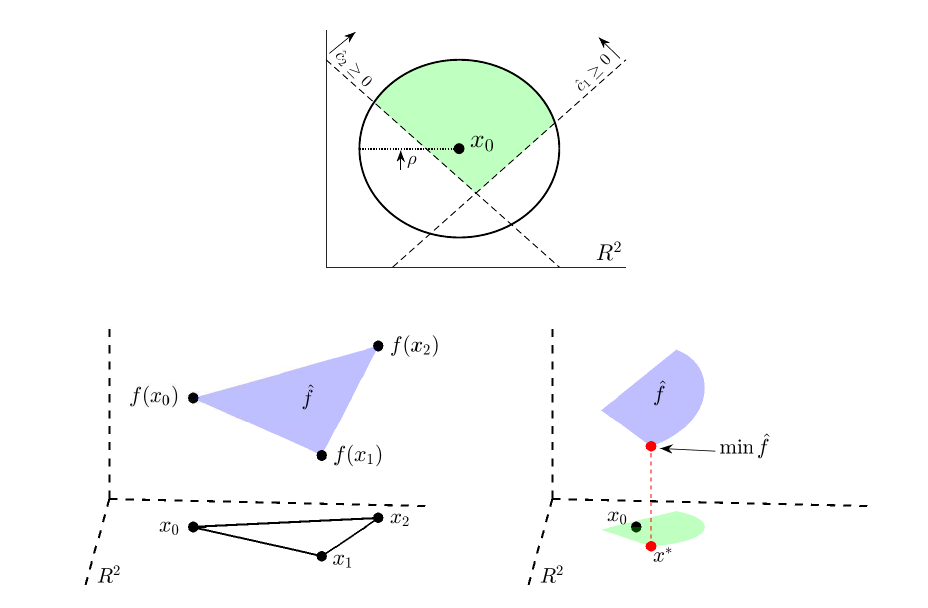
Figure A3. Minimization of ˆ f The candidate vertex x ∗ is computed by minimizing ˆ f ( x ) subject to the constraints ˆ c 1 , ˆ c 2 ≥ 0 within the trust region || x − x 0 || 2 ≤ ρ . (top) The region of optimization (green) is the intersection of the trust region || x − x 0 || 2 ≤ ρ with the half planes defined by the affine constraints ˆ c 1 ≥ 0 and ˆ c 2 ≥ 0. (bottom left) The function, ˆ f , to be minimized is represented graphically by the plane (blue) passing through points ( x 0 , f ( x 0 )) , ( x 1 , f ( x 1 )) , ( x 2 , f ( x 2 )) . (bottom right) The vertex x ∗ is defined to be the point within the region of optimization (green) at which ˆ f (blue) is minimized.